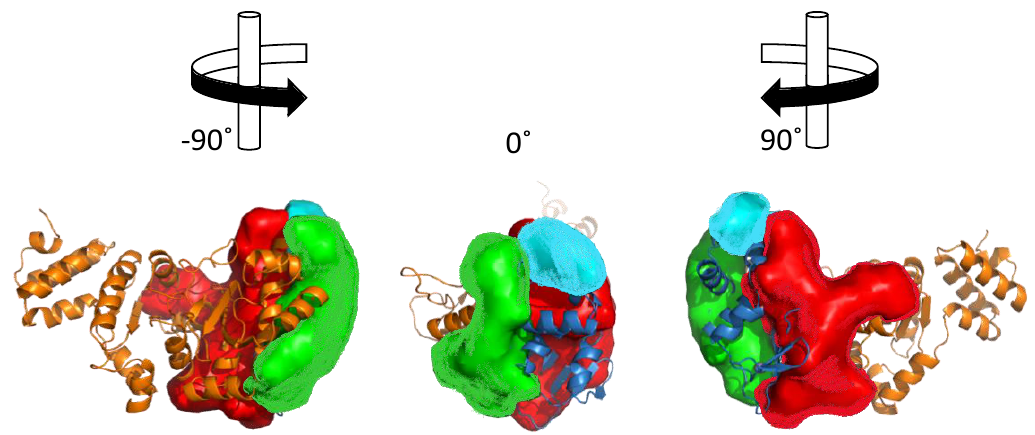
Figure 5. Cleft analysis of DnaG primase. Cleft analysis was performed using the web interface PDBsum (http://www.ebi.ac.uk/pdbsum) and crystal structure of DnaG from A. aeolicus (PDB ID 2AU3) [27].